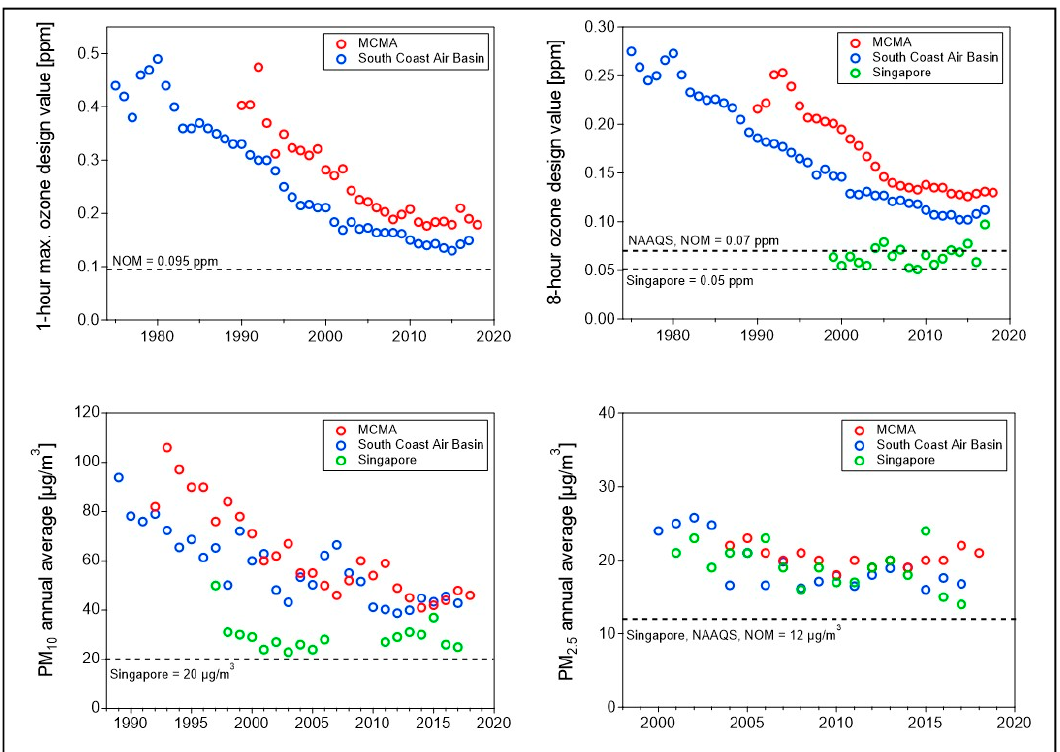
Figure 6. Comparison of air quality trends (for O 3 and PM) in the MCMA, South Coast Air Basin (SoCAB), and Singapore (graphs plotted by authors with data from SIMAT [22], South Coast Air Quality Management District [38], and Singapore Department of Statistics [39]).